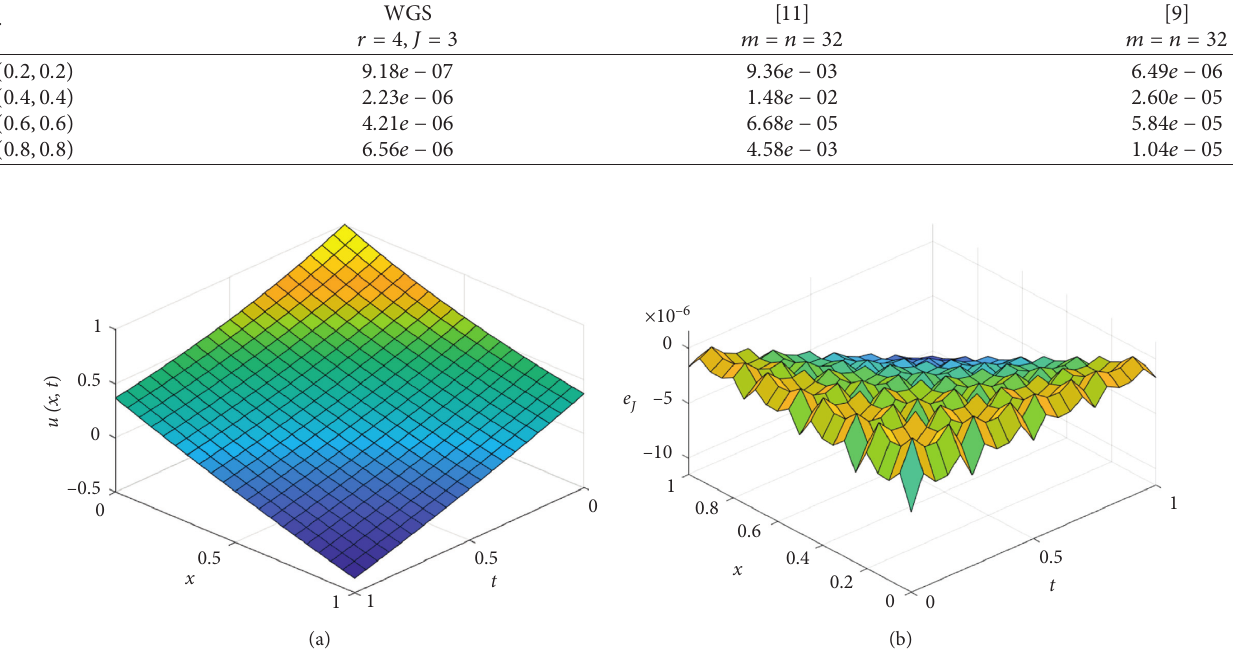
Figure 3: The surfaces of the approximate solution and the absolute error taking r � 4 and J � 2 for Example